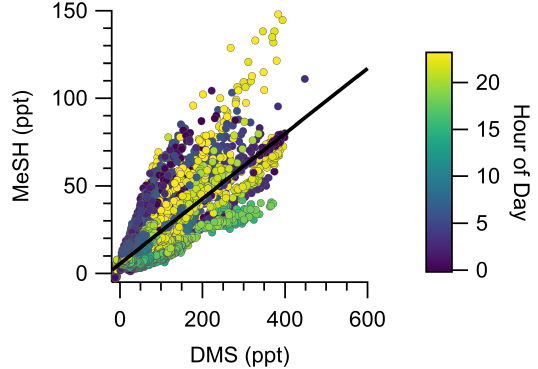
Figure 3. Correlation of DMS and MeSH mixing ratios at a 2min averaging time colored by hour of day of the observation. Hour of day is in local time (UTC − 7). The linear least squares best fit is plotted as the solid black line. The slope of the best fit line is 0.19, and R 2 = 0 . 61.